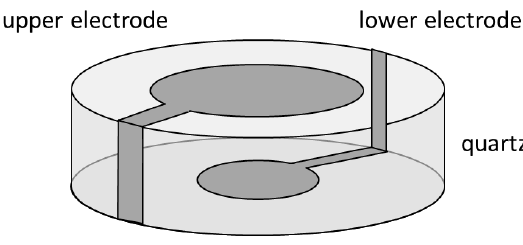
Figure 4. Typical QCM geometry, diameter ca. 10–30 mm, thickness ca. 0.3 mm (adapted from [64]).